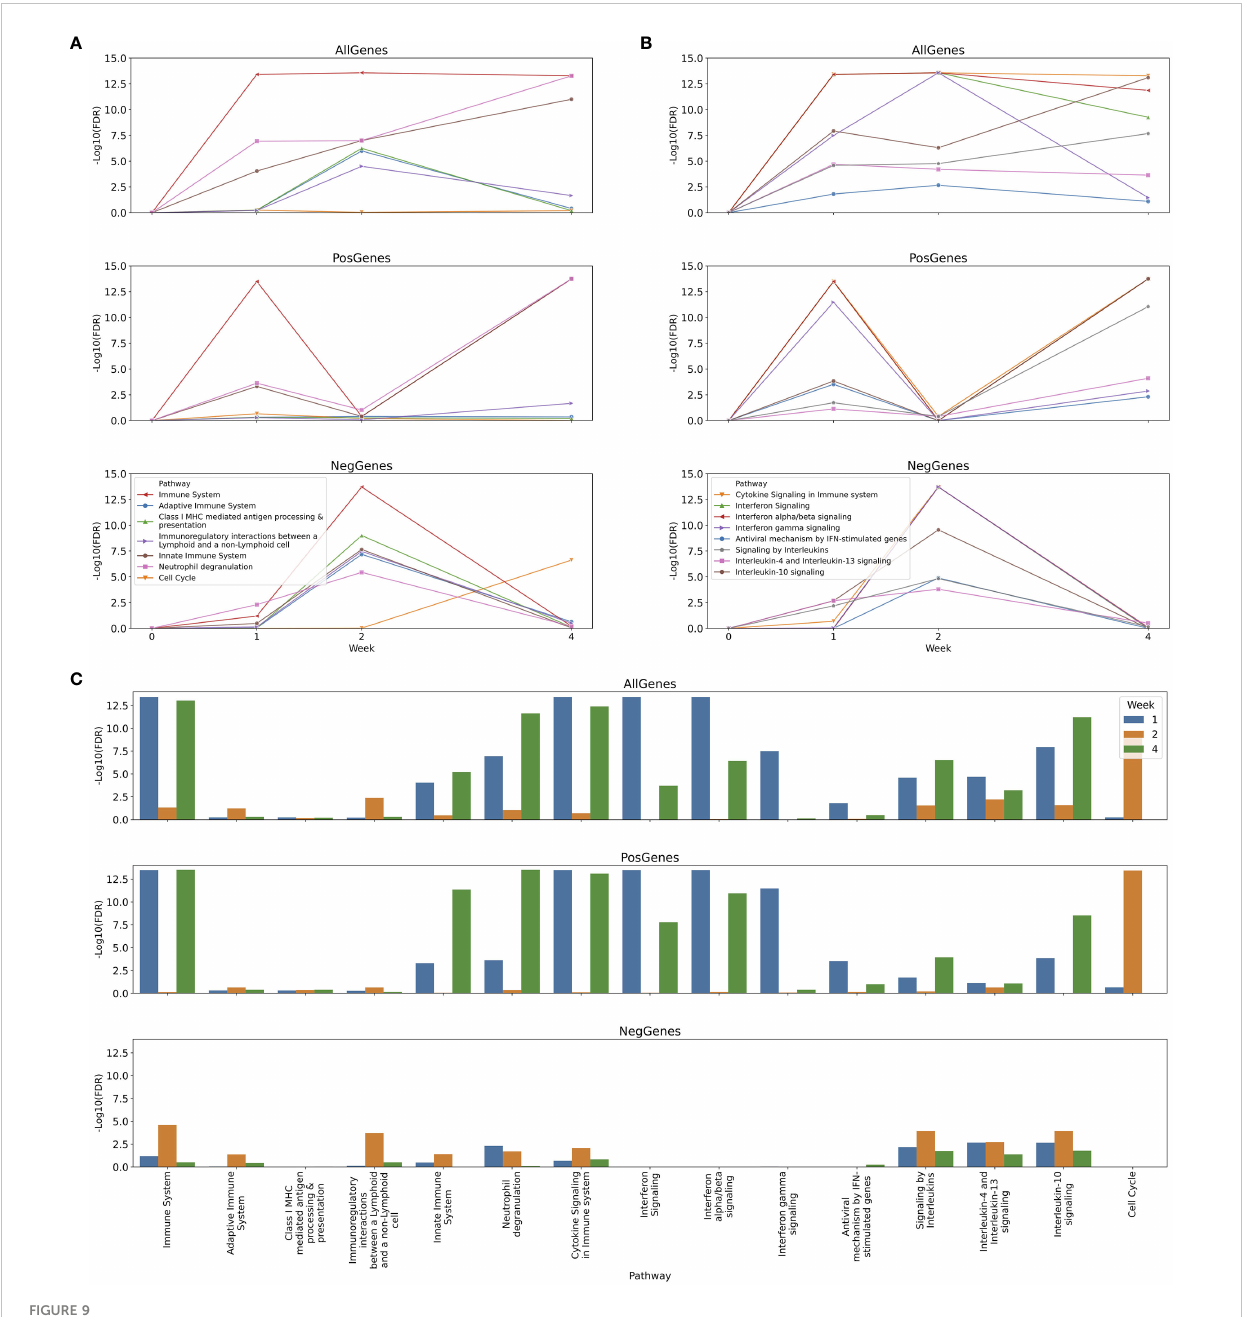
FIGURE 9 Longitudinal analysis of immune responses to yellow fever vaccines at one, two and four weeks post vaccination. (A) Temporal changes of major immune response pathways and cell cycle; (B) Temporal changes of cytokine signaling pathways during the fi rst four weeks post vaccination; (C) Immune response pathways enriched for genes signi fi cantly differentially expressed at one, two and four weeks post vaccination. In (A, B) the differential gene expression analysis was conducted between two consecutive time points (e.g. between one week and two weeks), while in C the analysis conducted between the indicated week vs 0 week post vaccination. All analyses were conducted three times for all differentially expressed genes, up-regulated genes and down-regulated genes, respectively, to infer directions (i.e. up or down) of pathway activity